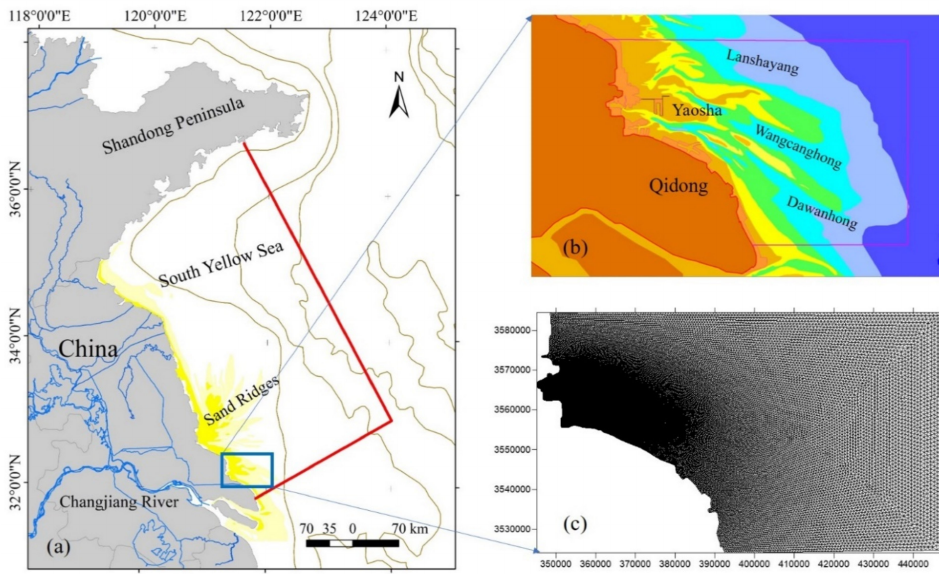
Figure 2. Computational domains of Jiangsu regional model ( a ), and Tongzhou Bay scope ( b ) and model ( c ).